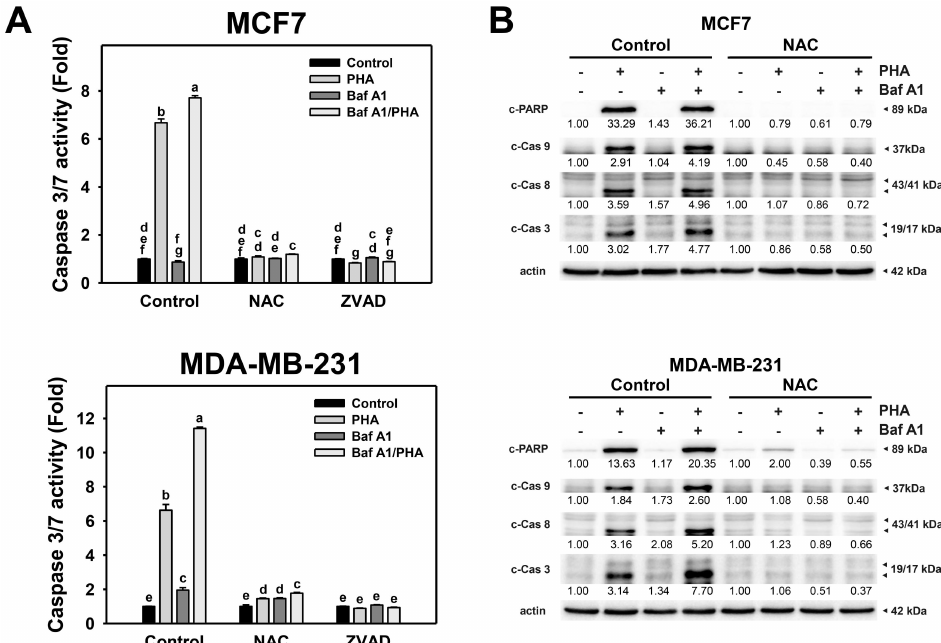
Figure 7. Autophagy downregulation promotes PHA-triggered activations of Caspase 3/7 and apoptotic signaling in breast cancer cells. ( A ) Caspase 3/7 activation. Cells were pretreated with NAC (10 mM for 1 h) or ZVAD (100 µ M for 2 h) and then co-treated with PHA (control and 5 µ M) and Baf A1 (control and 100 nM) for 24 h. ( B ) The impact of NAC effect on PHA-triggered apoptosis signaling. Cells were pretreated with NAC (10 mM for 1 h) and then co-treated with PHA (control and 5 µ M) and Baf A1 (control and 100 nM) for a 24 h treatment. Data, means ± SDs ( n = 3). Data with non-overlapping lower-case letters differ significantly ( p < 0.05 to